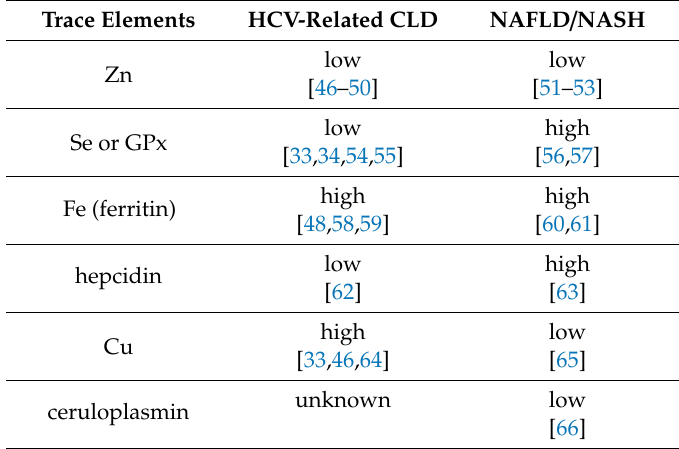
Table 2. Comparisons of the status of trace elements between HCV-related CLD and NAFLD / NASH.